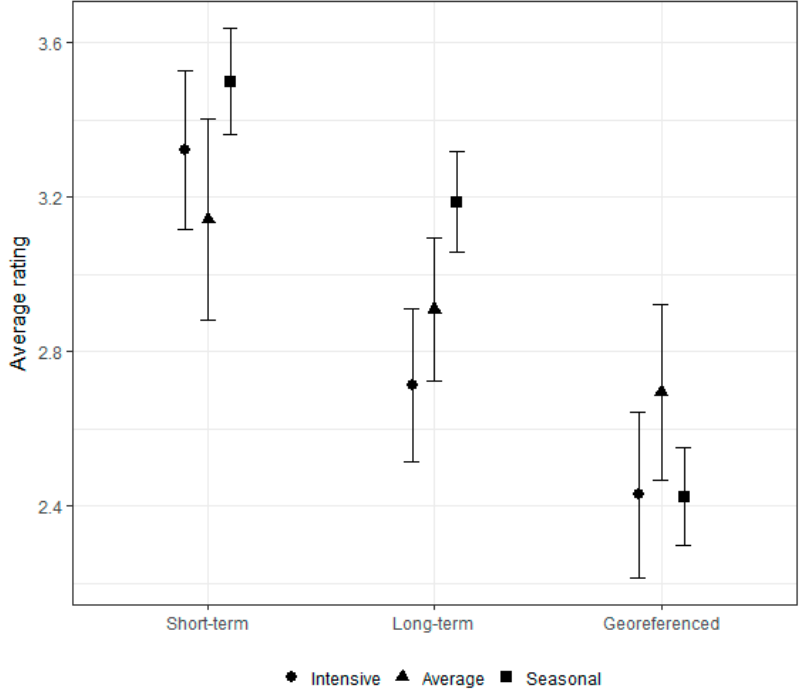
Figure4. Experiment2: Averageratinggiventoitemsfromthedi ff erentrecommendationmethodologies Figure 4. Experiment 2: Average rating given to items from the different recommendation considering di ff erent consumption methodologies considering different consumption profiles.